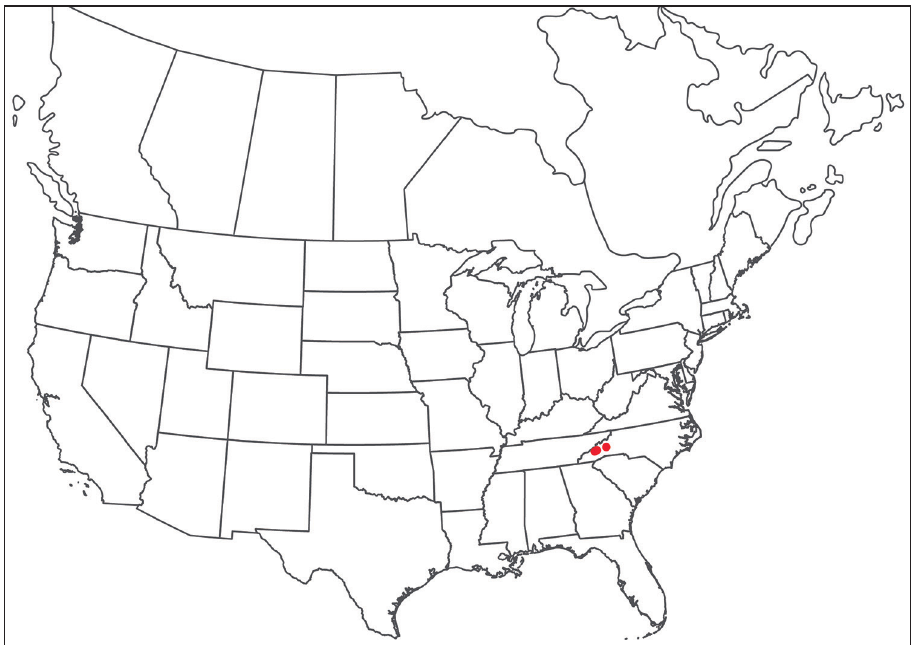
Figure 275. Torrenticola whitneyae sp. n.